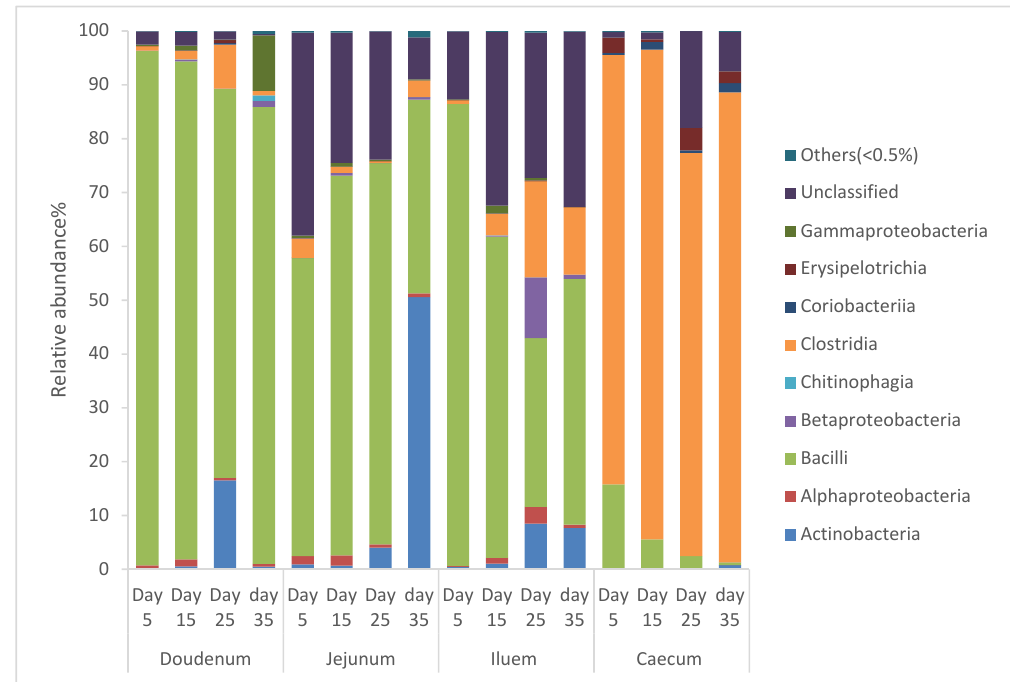
Figure 1. Percentage of relative abundance of bacterial community of Cobb 500 broiler chickens determined from different intestinal segments at different age periods from 16S rDNA libraries.